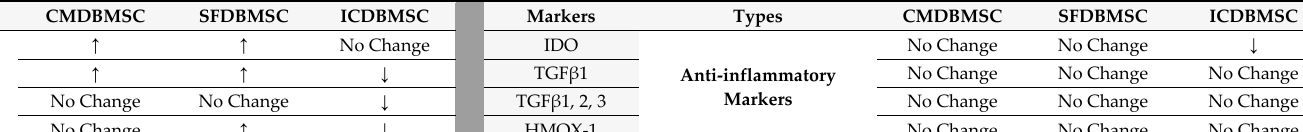
Table 2. DBMSC (CMDBMSC, SFDBMSC, and ICDBMSC) effects on macrophage expression of different functional markers, costimulatory molecules, co-inhibitory molecules, antigen presenting molecule, inflammatory cytokines, and anti-inflammatory markers as compared to untreated macrophages by flow cytometry recorded by mean of fluorescent intensity (MFI). Increased ( ↑ , p < 0.05), decreased ( ↓ , p < 0.05)), and no change ( p > 0.05).